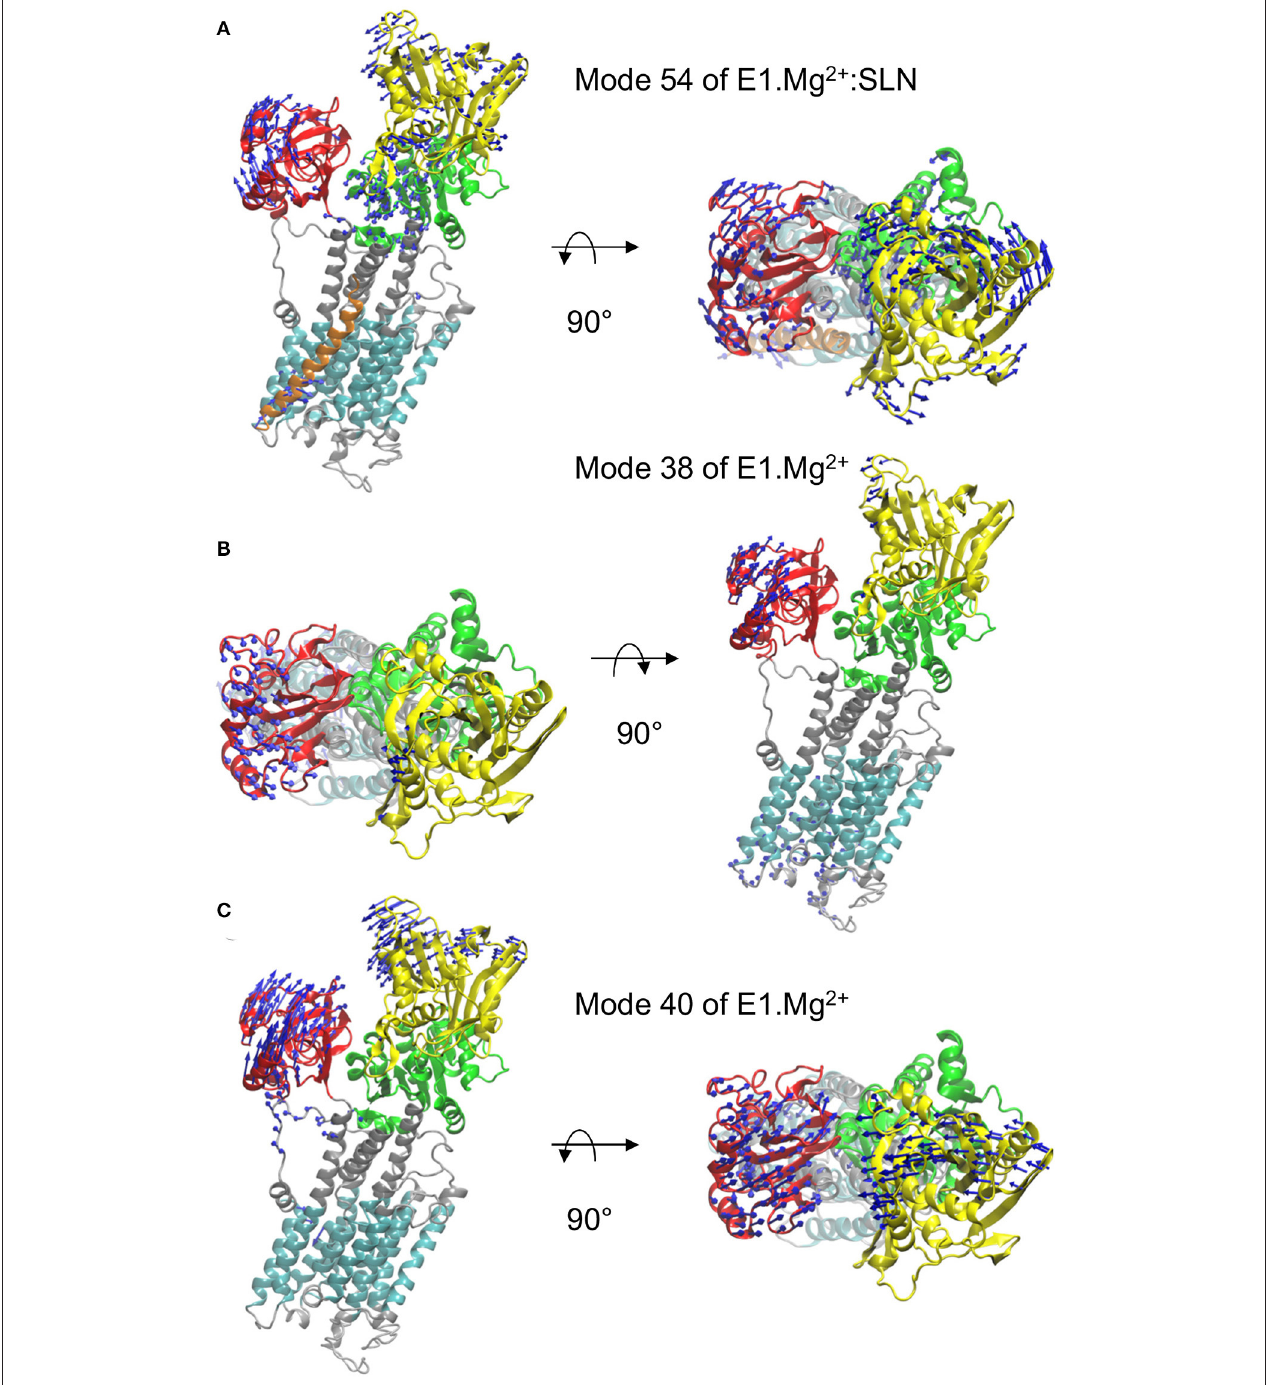
FIGURE 3 | Motions along the three modes identified from the overlaps. In each of the three panels, a profile view and a top view of the protein are presented. The same color code as in Figure 1A is used, i.e., the N-, P-, and A-domains are in yellow, green, and red, respectively, the TM domain in cyan and the rest of the protein in gray. The directions of motions are shown as blue arrows. The lengths of the arrows are proportional to the amplitude of displacement of the C α atoms when the entire system is displaced by mass-weighted RMSD of 3 Å. For clarity, the arrows corresponding to displacement amplitudes under 3 Å are omitted. The motions are shown along mode 54 of E1.Mg 2 + :SLN (A) and along modes 38 (B) and 40 (C) of E1.Mg 2 +